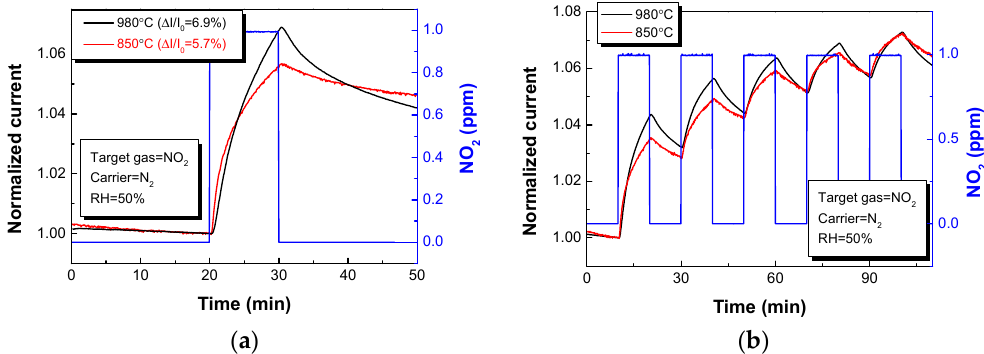
Figure 2. ( a ) Normalized current of the chemi-resistors upon exposure to 1 ppm of NO 2 under ambient conditions; ( b ) Real-time current behavior of the chemi-resistors upon exposure to 5 sequential pulses of NO 2 at 1 ppm. In both panels, the current is normalized to the value of the gas inlet during the first pulse. The blue line refers to the NO 2 flow injections. The red and black lines refer to sensors based on graphene grown at 850 °C and 980 °C, respectively.